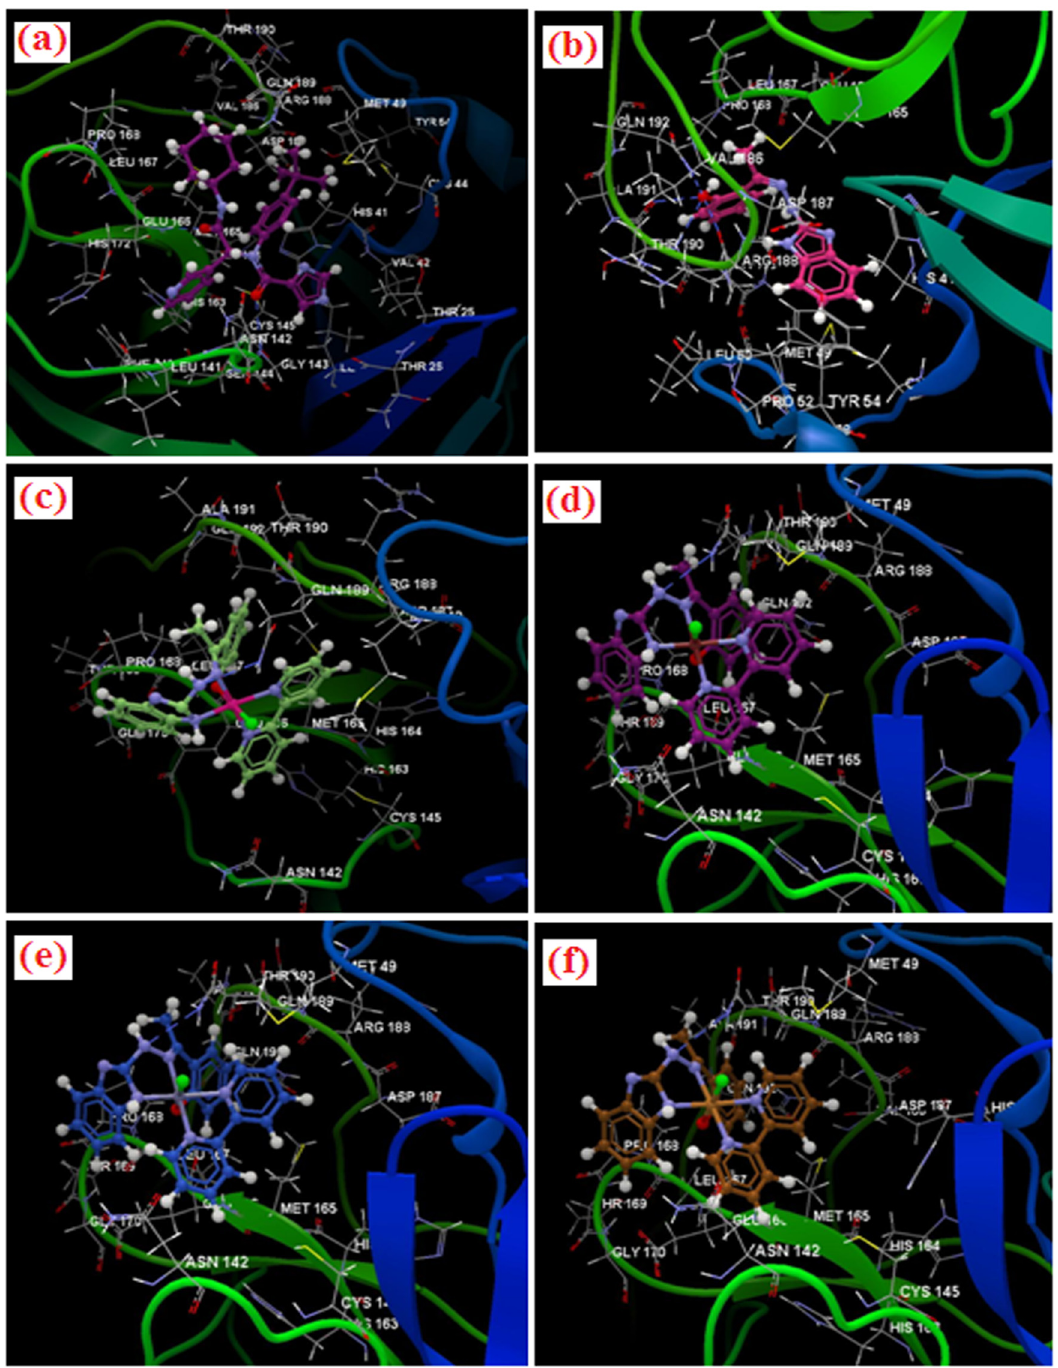
Figure 5: Docking pose of the compounds interacting with the amino acid residues of binding site of 4Z6S; ( a ) co - crystallized X77, ( b ) Schi ff base ligand, HL, ( c ) Co ( II ) complex, ( d ) Ni ( II ) complex, ( e ) Zn ( II ) complex and ( f ) Cu ( II )